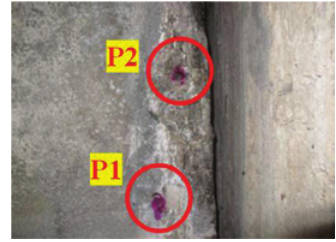
fig. 14. Corrosion of reinforcement